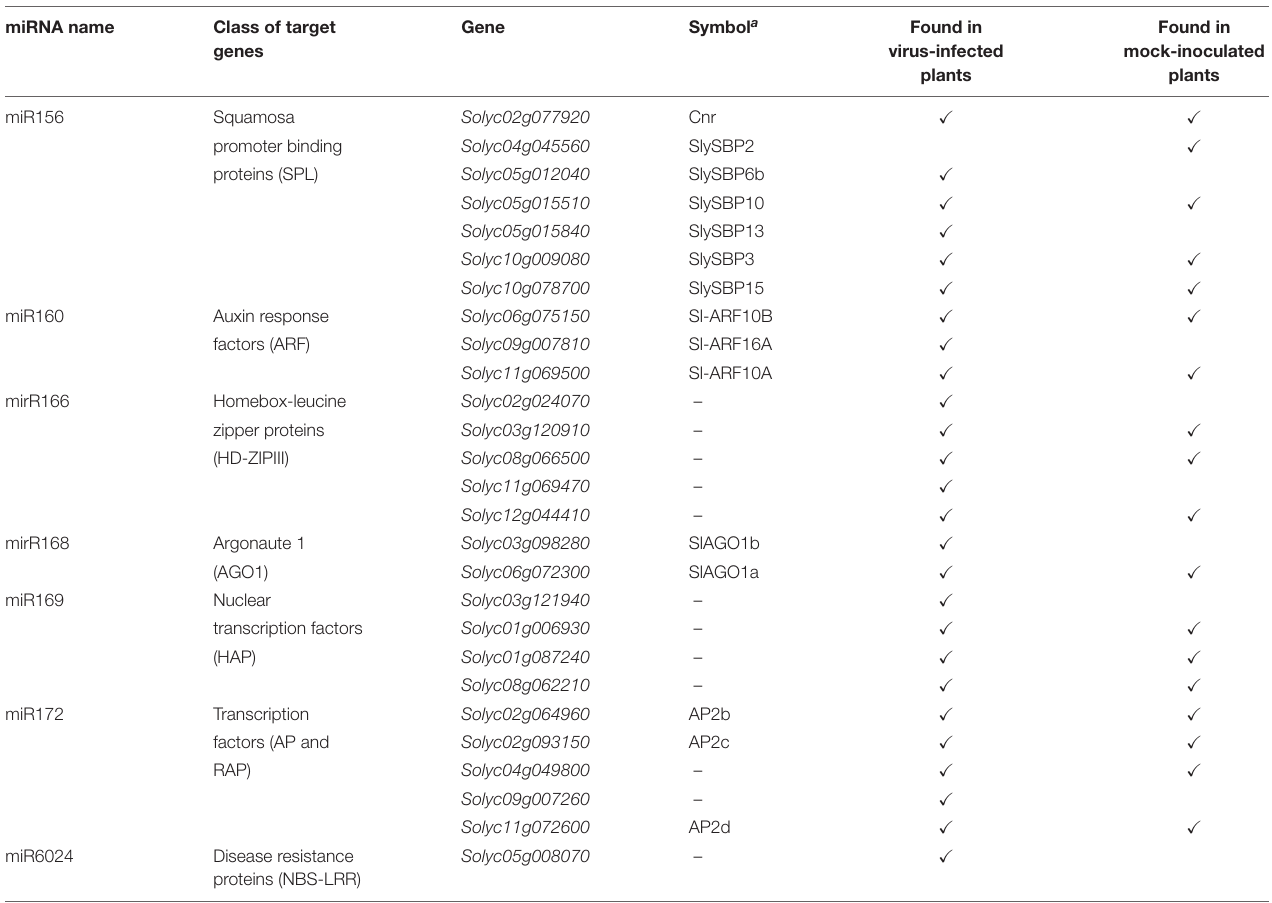
TABLE 1 | Target genes found to be cleaved by miRNAs in the PARE analysis either in mock-inoculated or virus-infected tomato plants. miRNA